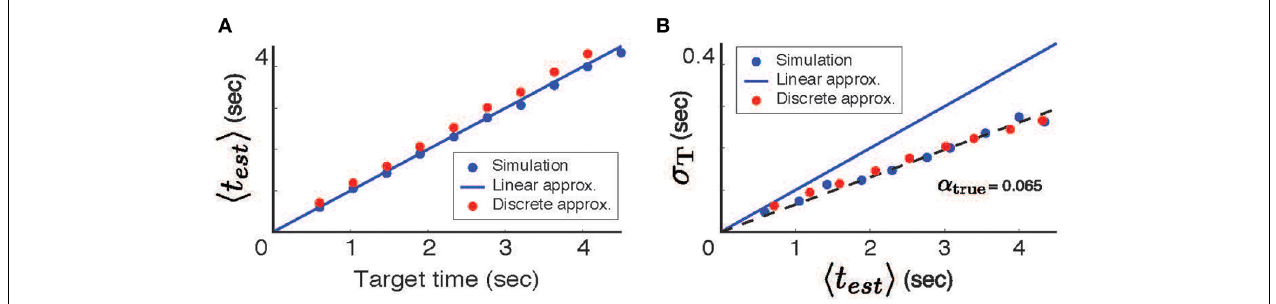
FIGURE 3 | Unbiased estimates obtained using a learned threshold. (A) The mean estimated time ( (cid:5) t est (cid:6) ) as a function of the target time. (B) The standard deviation of the estimate error ( σ T ) as a function of the mean estimate.